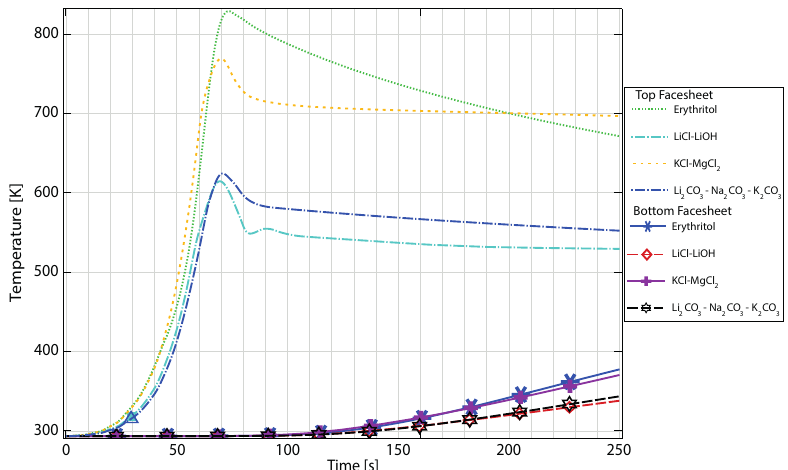
Figure 12. Temperature evolution on top and bottom face sheets for different